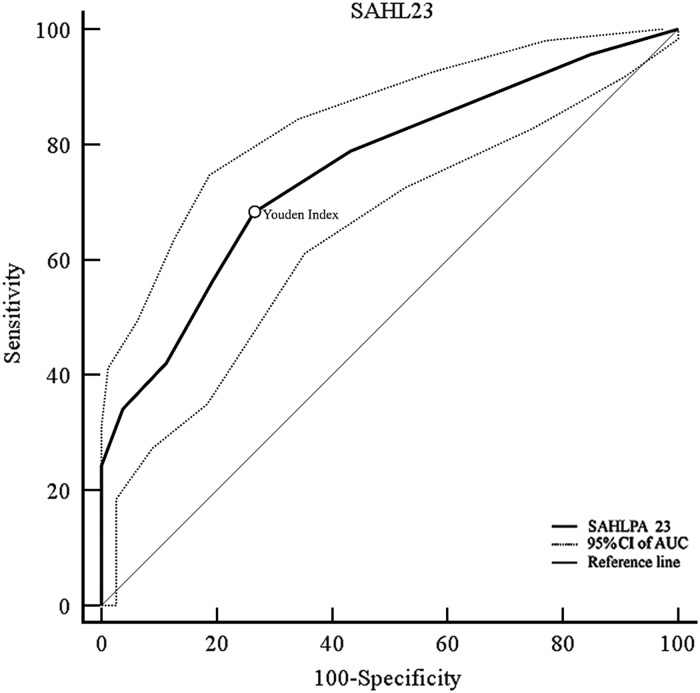
Receiver operating characteristic curve for detection of inadequate health literacy (N=484). SAHL=Short Assessment of Health Literacy; SAHLPA=Short Assessment of Health Literacy for Brazilian Portuguese-speaking adults; CI=confidence interval; AUC=area under the curve.